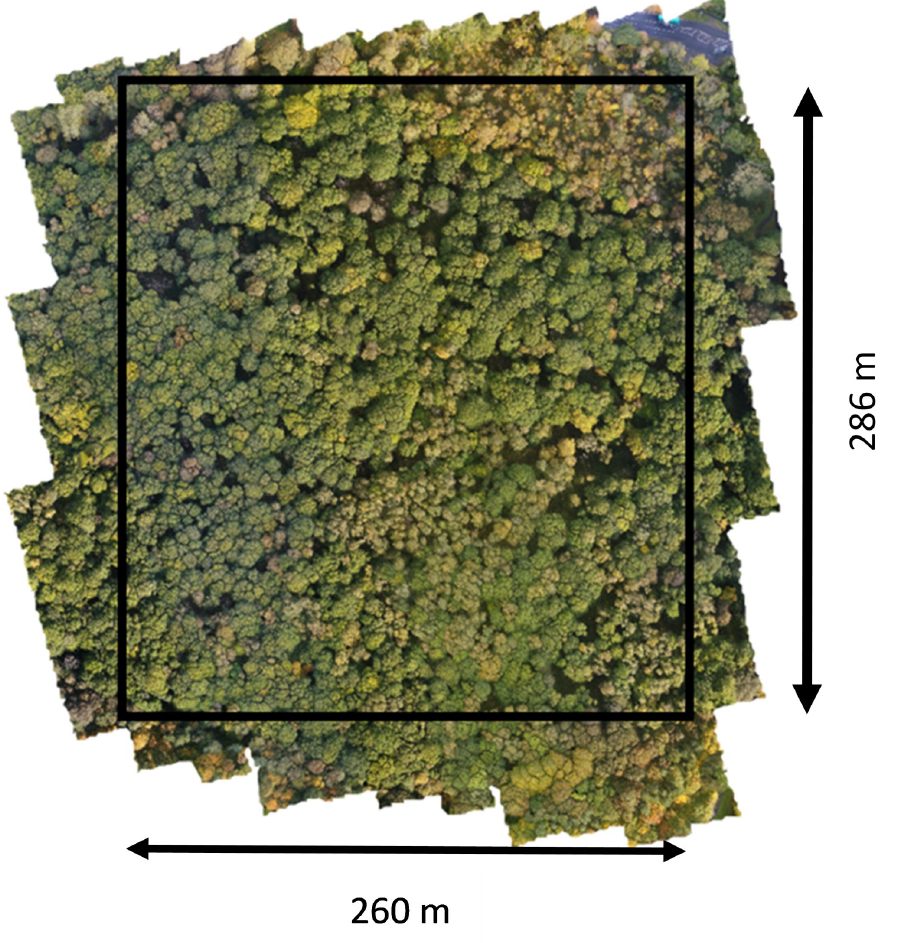
Fig 2. Visible mode software stitched image of Priestclose Wood with actual area used for